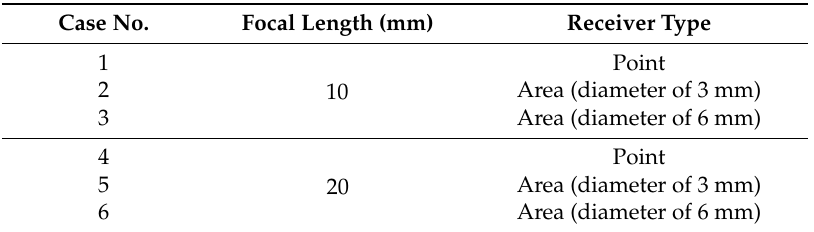
Table 1. Various combinations of focal length and receiver type in FZP sensors.